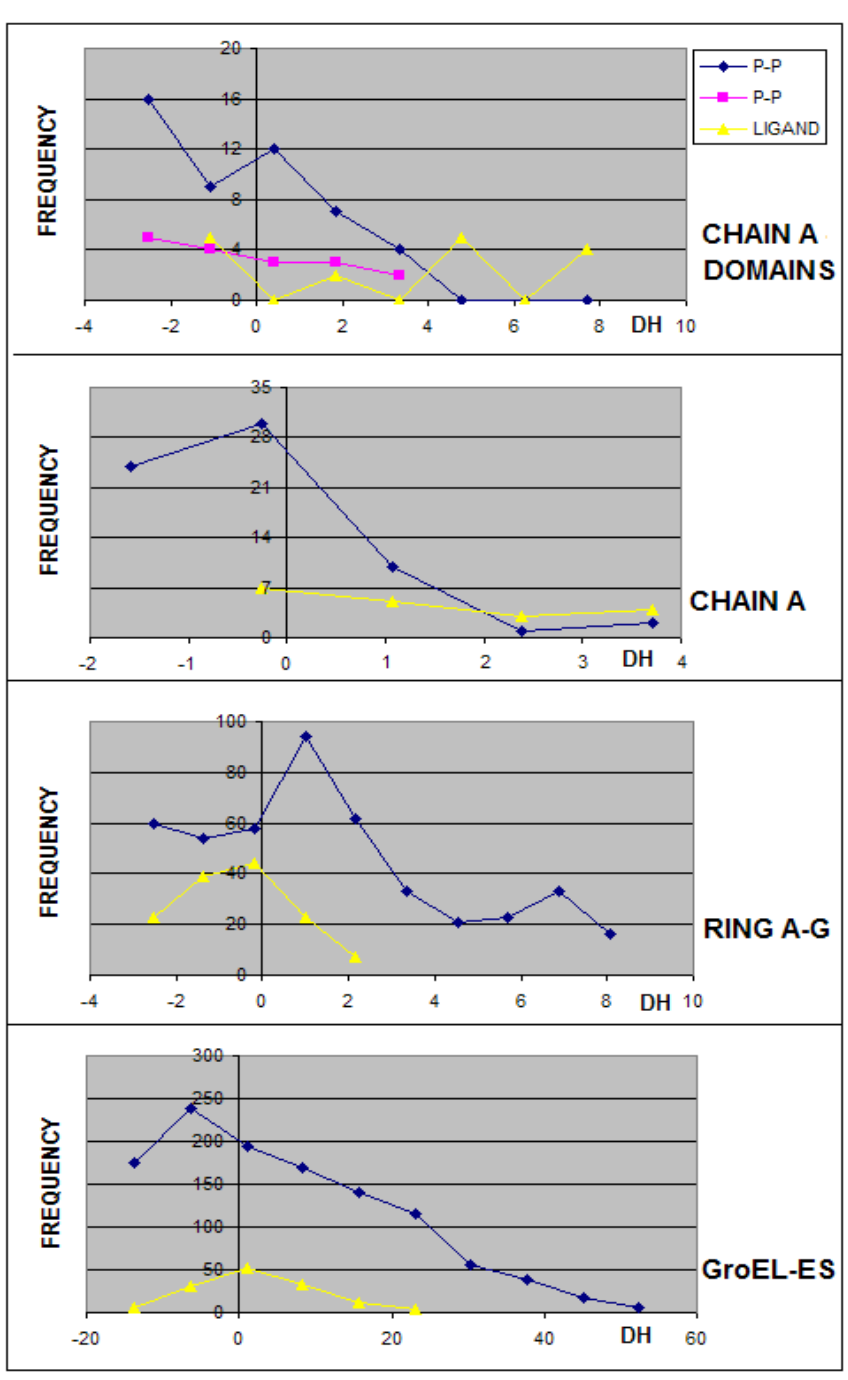
The accordance of protein-protein interaction area with expectations based on “fuzzy oil drop” model is lower in chain H than in chain A. ~ Figure 4 . Frequency of the values of H Δ representing the residues in chain A engaged in protein-protein (P-P) interaction (the dark blue and pink curves – interaction of two ~ domains) and in ligand complexation. The negative H Δ characterize the residues engaged in this type of interaction. Ligand complexation is represented by residues of ~ positive H Δ values when the domain is taken as the